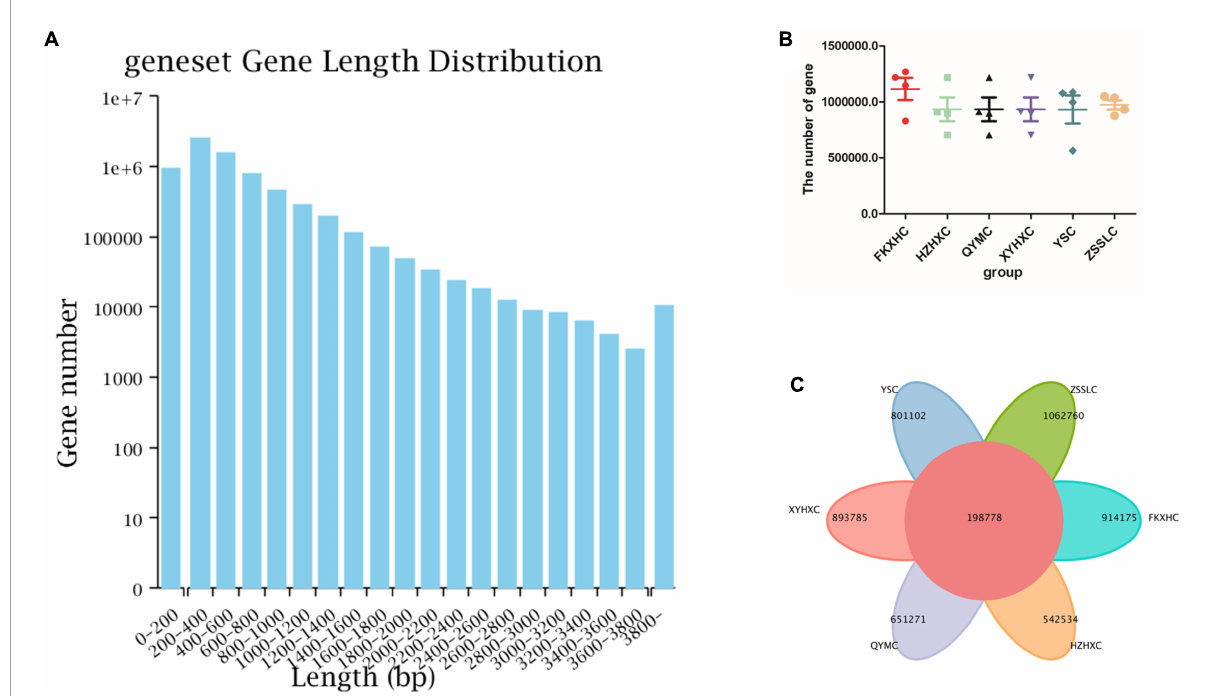
FIGURE1 Gene abundance statistics. (A) Gene length distribution, X -axis: length of the genes, Y -axis: number of genes of the total genes. (B) Scatter dot plot showing the difference in gene numbers among the six groups. (C) Venn diagram showing the numbers of common and unique genes among the six groups. Data are expressed as means ±